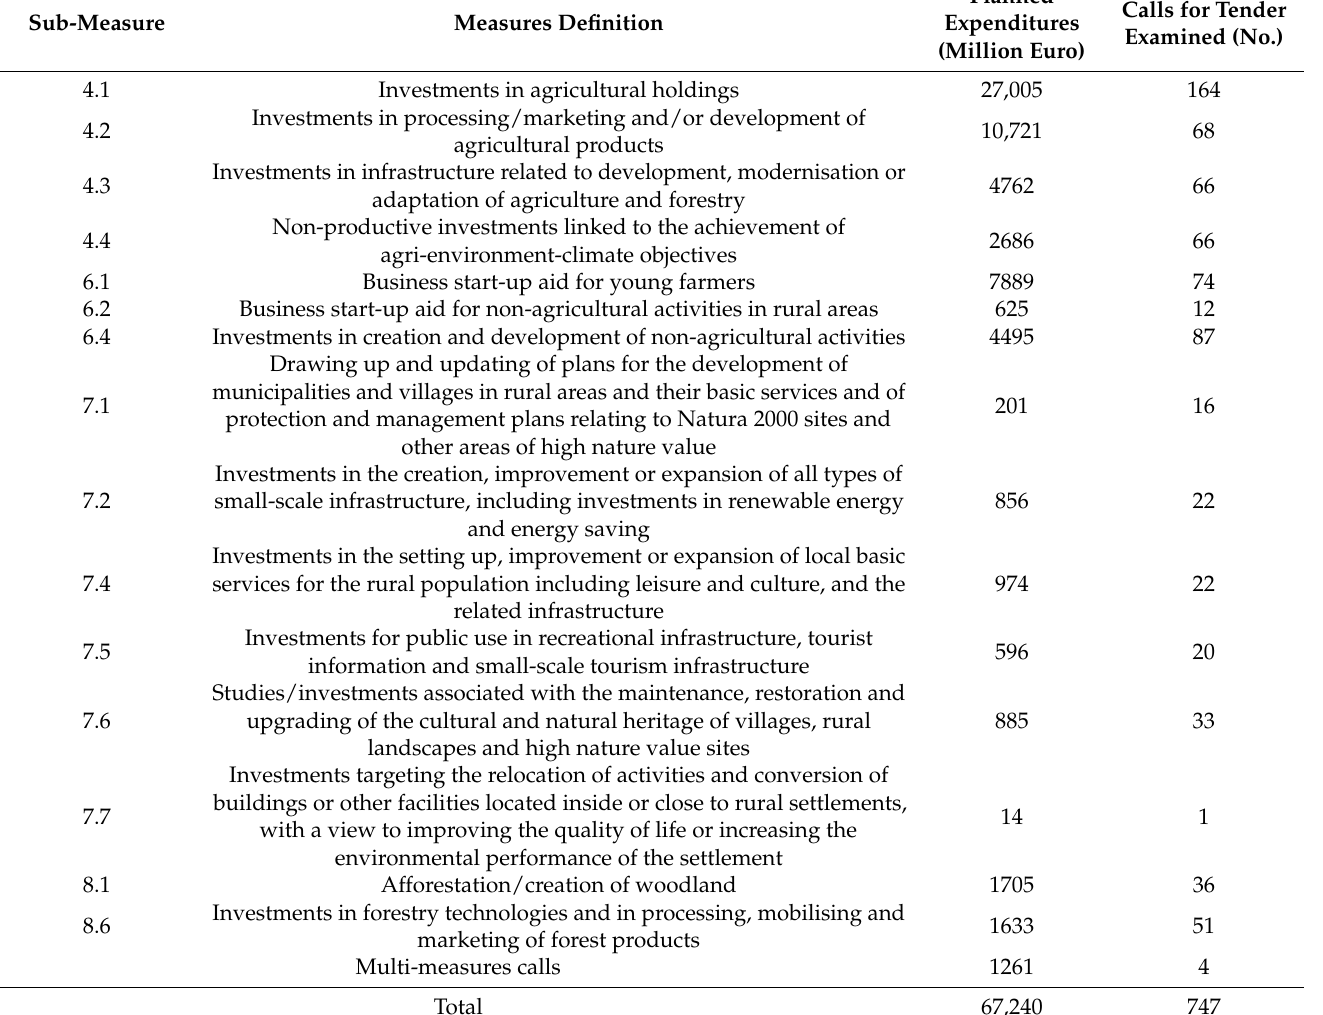
Table 1. The RDP investment sub-measures, planned expenditures in 2014–2020 period and no. of calls for tenders